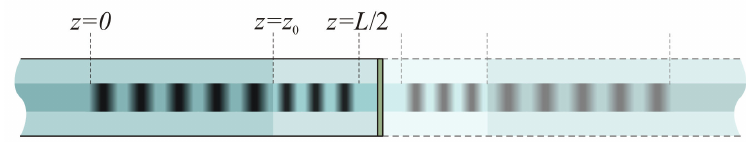
Figure 10. Equivalent scheme of reflective LPFG structure with π